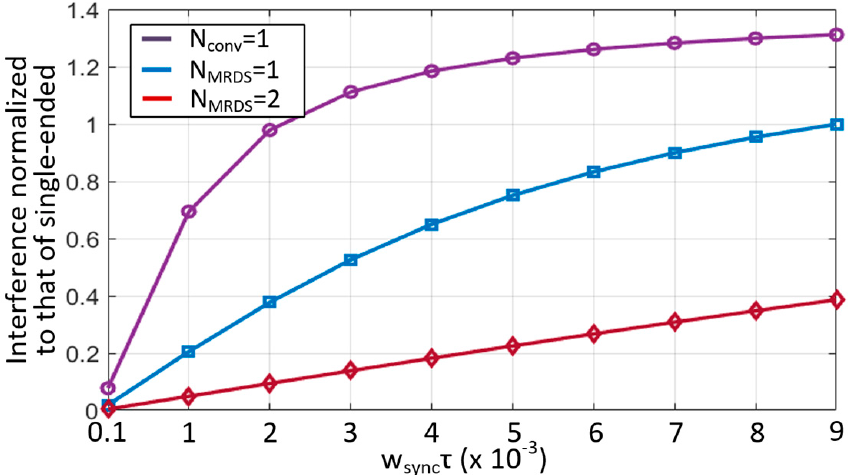
Figure 6. Comparison of interference cancellation effect in a conventional differential sensing and proposed MRDS scheme.